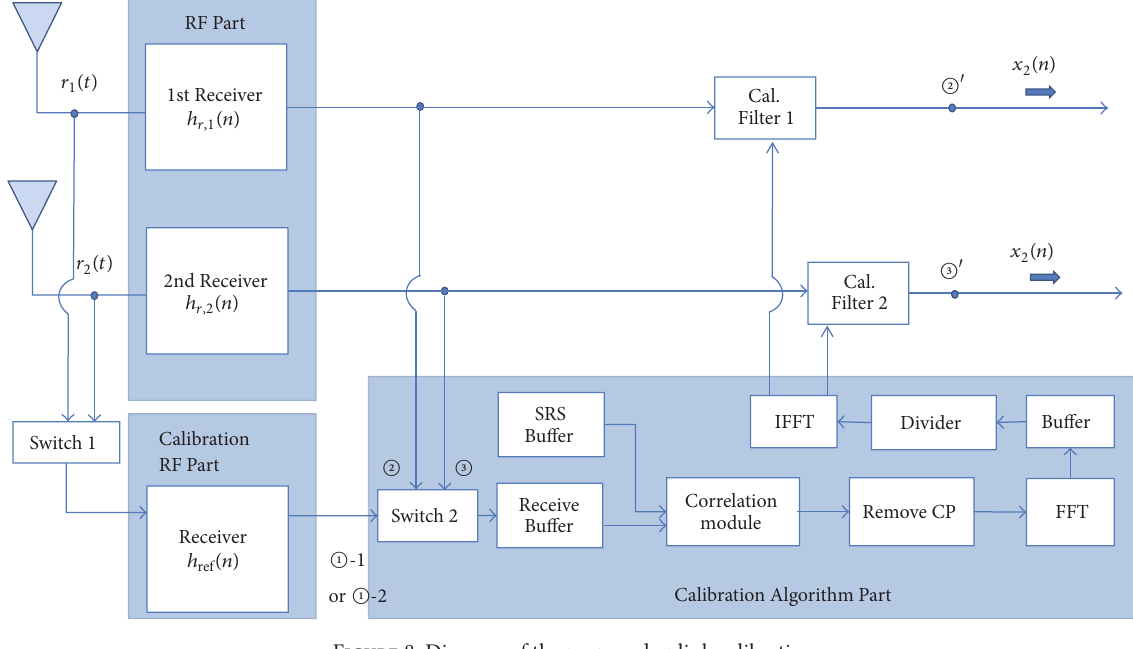
Figure 8: Diagram of the proposed uplink calibration.